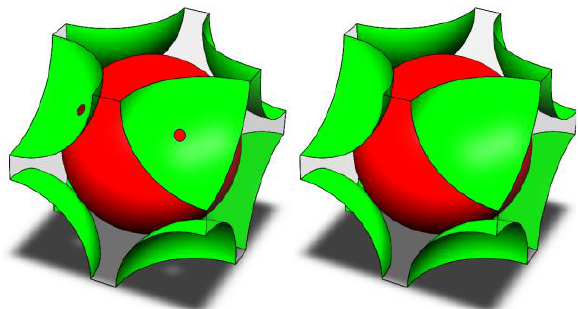
Fig. 3. Axonometric view of the analysed geometry with (left) and without (right) additional cylindrical volumes between the individual